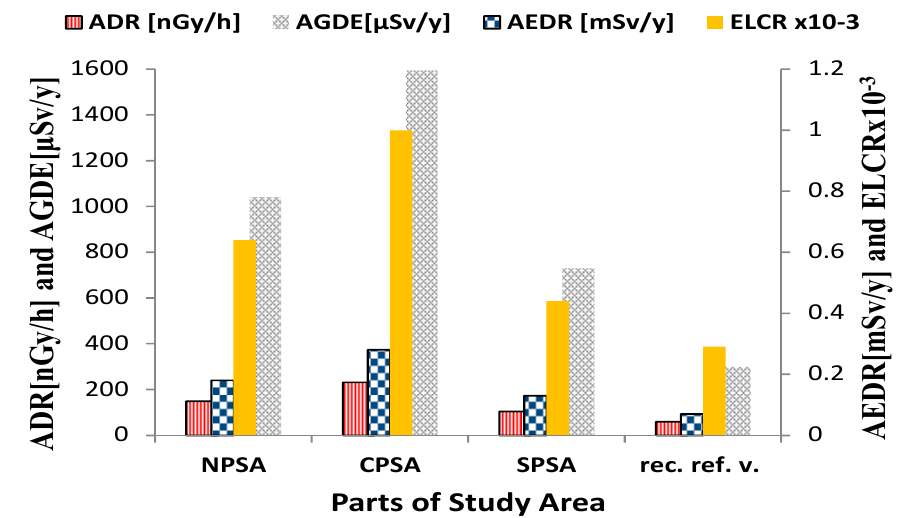
Figure 7. The average absorbed dose rate (ADR), annual effective dose rate (AEDR), annual gonadal dosage equivalent (AGDE) and excess lifetime cancer risk (ELCR) in the three parts of the study area (compared to the worldwide average). Table 2. Range and mean values for the radiological parameters of the studied granitic samples from the 3 parts of the Eastern Desert.